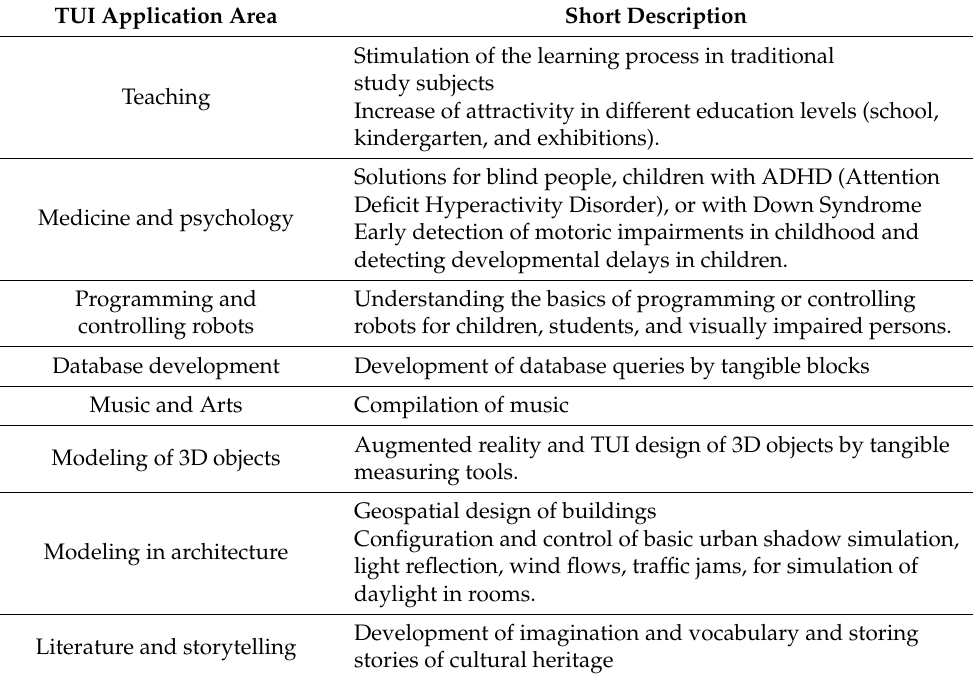
Table 1. The most common TUI application